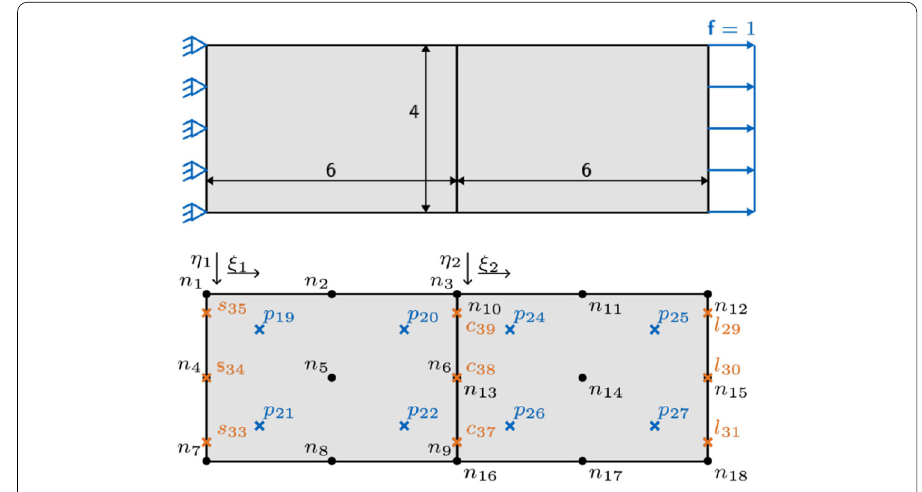
Fig. 22 Example two-patch model: two patches, both of size 4 × 6, are coupled at the common interface. Moreover, the left patch has a Dirichlet boundary condition on its left edge and the right patch has a Neumann boundary condition of f = 1/unit on its left side. The quadratic patches have both 9 control (black points) and 4 quadrature points (blue crosses). For the integration along the edges 3 quadrature points (orange crosses) are